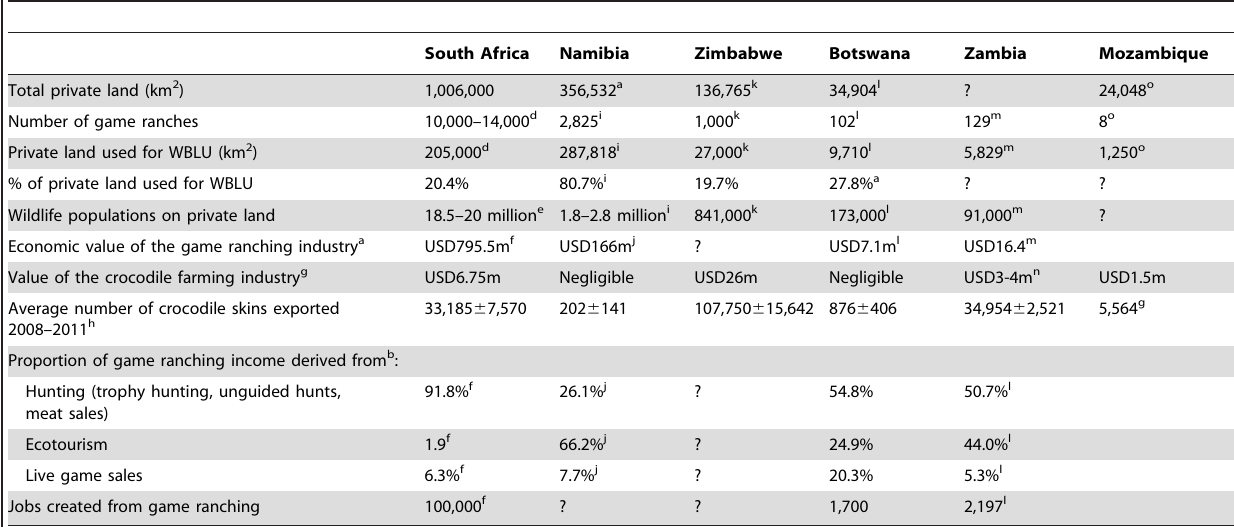
Table 5. The scale of the regional game ranching industries (in the case of Zimbabwe, the historic scale, pre-land seizures after which many game ranches were converted into subsistence livestock farms).